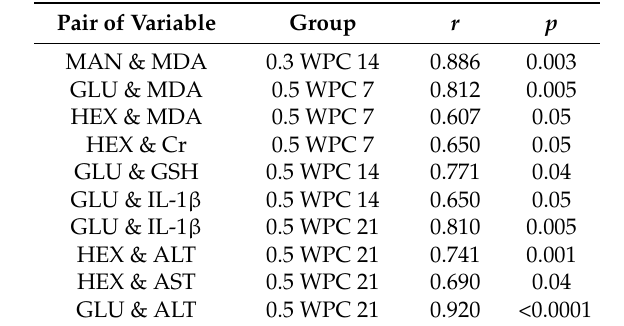
Table 4. Correlations between the profile of lysosomal exoglycosidases, oxidative stress and biochemical parameters in rats fed with WPC-80.